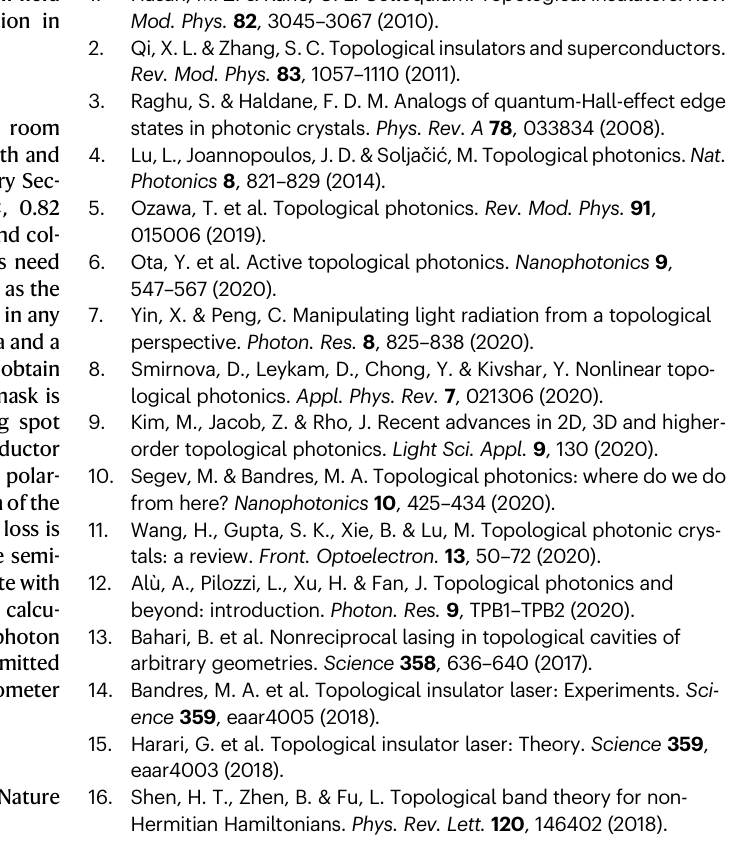
pathlengths.Top:differentialpathlengthequalsto0.Bottom:differentialpath lengthequalsto~7.5mm. f Visibilityatvarieddifferentialpathlengths,whichis inLorentzlineshapewithafull-widthathalfmaximum(FWHM)of9.5mm.Such a FWHM corresponds to a coherence time of 0.023ns, and a spectral FWHM of ~0.11nm,whichmatcheswiththeonemeasuredbyspectrometer.Circles:data, line: fi